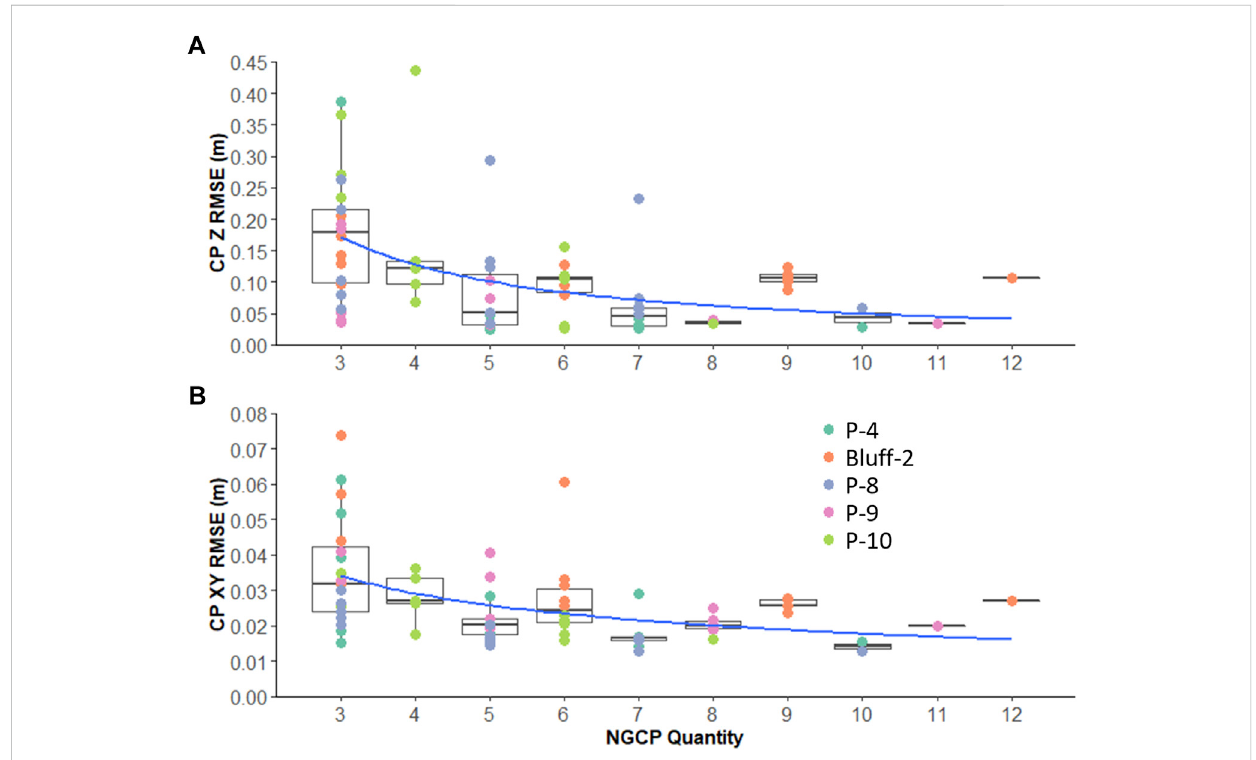
FIGURE 6 NGCP quantity vs. vertical (Z) RMSE (A) and horizontal (XY) RMSE (B) . Each point represents the RMSE of a single replication for a given quantity of NGCPs, while point colors represent the site from which the RMSE is derived. Boxes represent the interquartile range (IQR), whiskers represent points < 1.5*(IQR) above or below the IQR, and dots represent points > 1.5*(IQR) above or below the IQR. Blue lines represent trend lines with the form: y (cid:1) axby (cid:1) axb. Outliers greater than 3 times the interquartile range above the upper quartile of each NGCP quantity are not shown (top n = 6, bottom n =